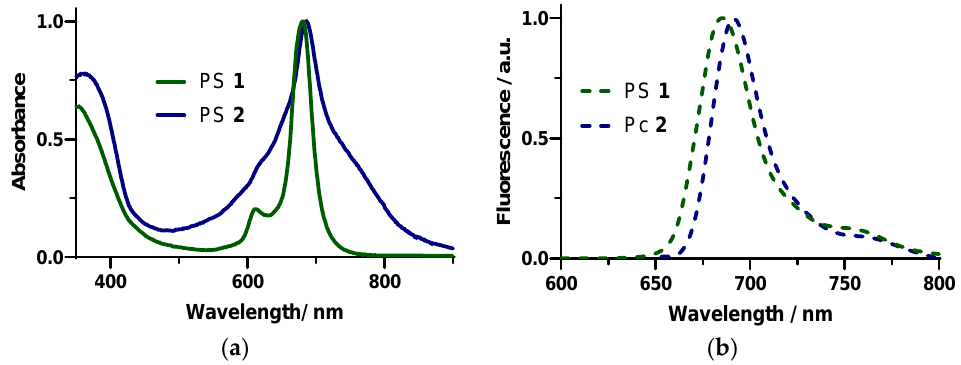
Figure 1. Normalized ( a ) absorption and ( b ) emission spectra of compounds 1 and 2 in DMF at 298 K (λ exc PS 1 = 680 nm and λ exc PS 2 = 643 nm).